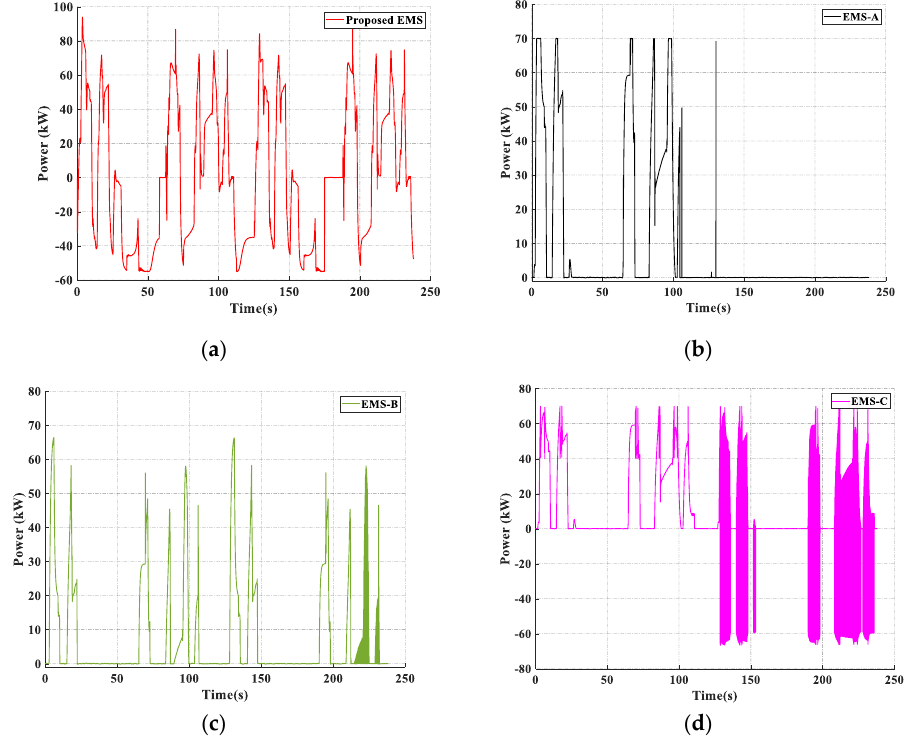
Figure 18. Power from the supercapacitor in the proposed case and conventional cases. ( a ) Proposed EMS; ( b ) EMS-A; ( c ) EMS-B; ( d )